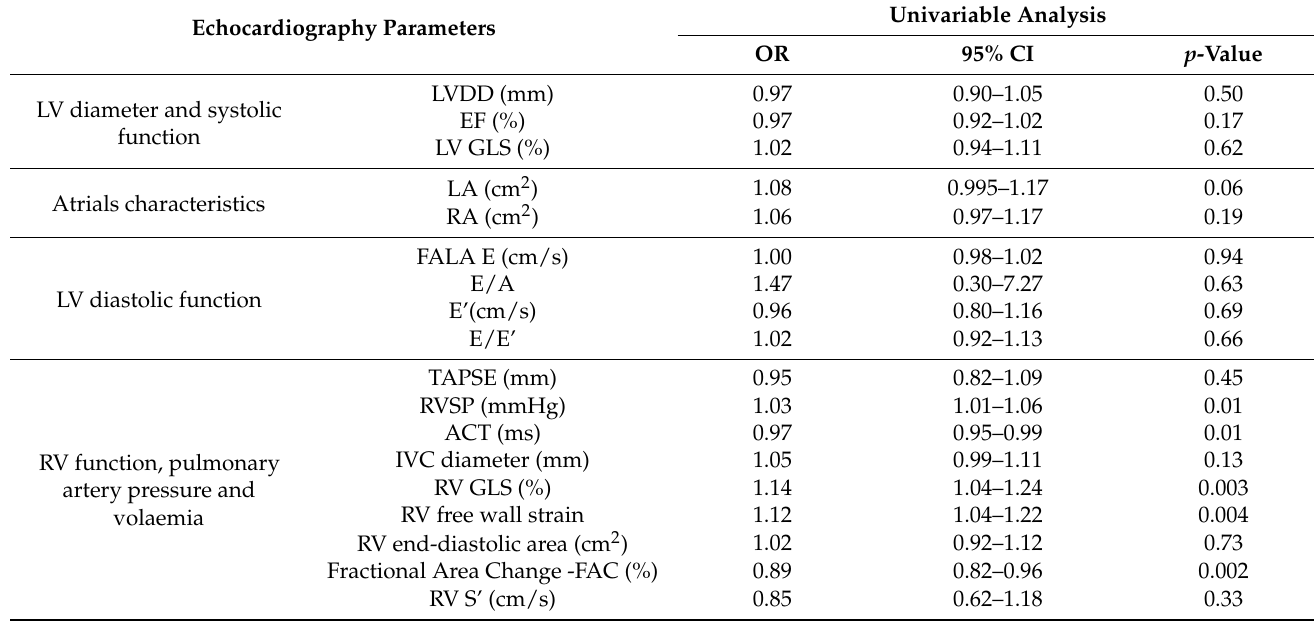
Table 5. Diagnosis of low performance status (ECOG 2) in relation to main parameters of echocardio- graphy. Univariate logistic